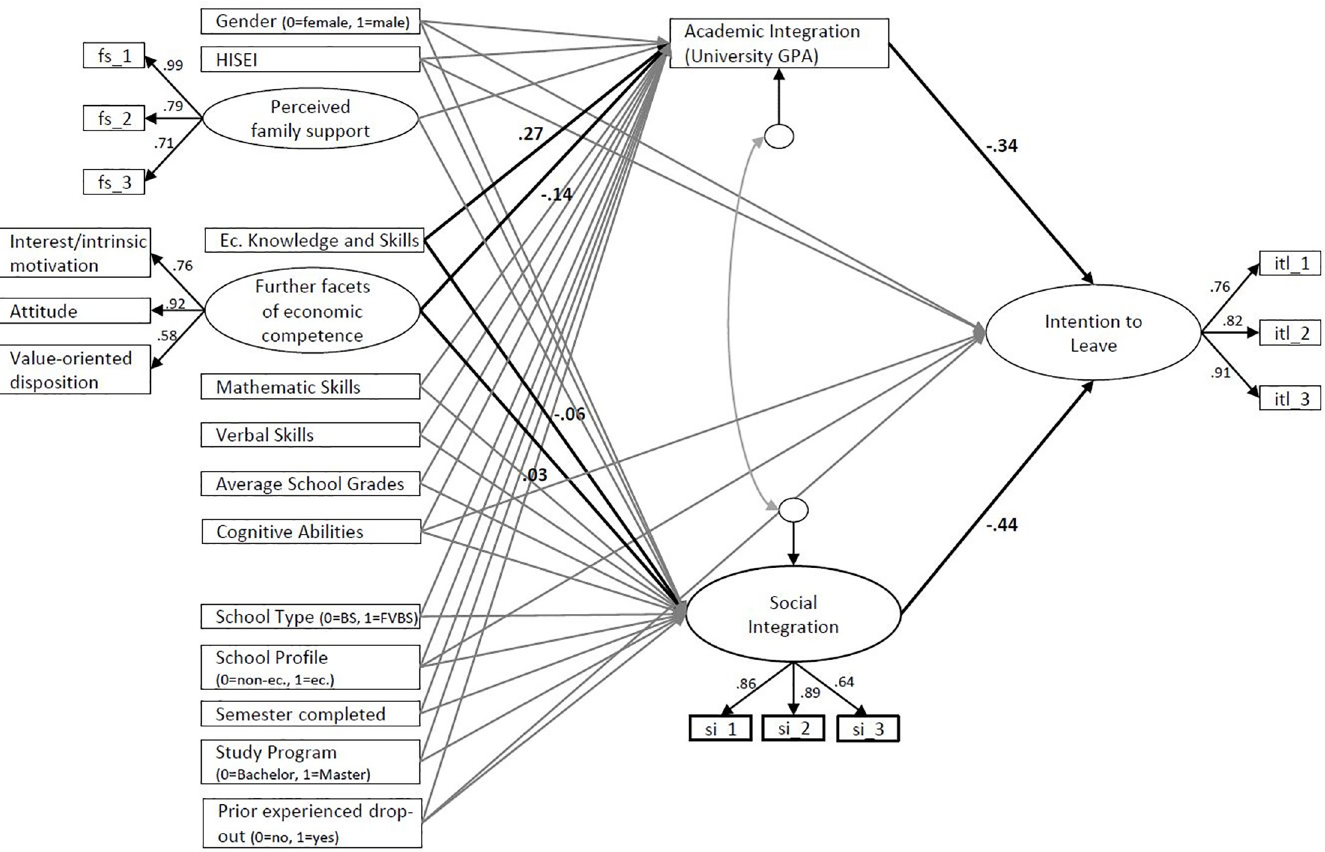
Fig 3. Path diagram regarding the effects of economic competencies on the intention to leave economics studies at university. Ec. = Economics, GPA = Grade Point Average, UGPA = University Grade Point Average, BS = Baccalaureate School, FVBS = Federal Vocational Baccalaureate School.